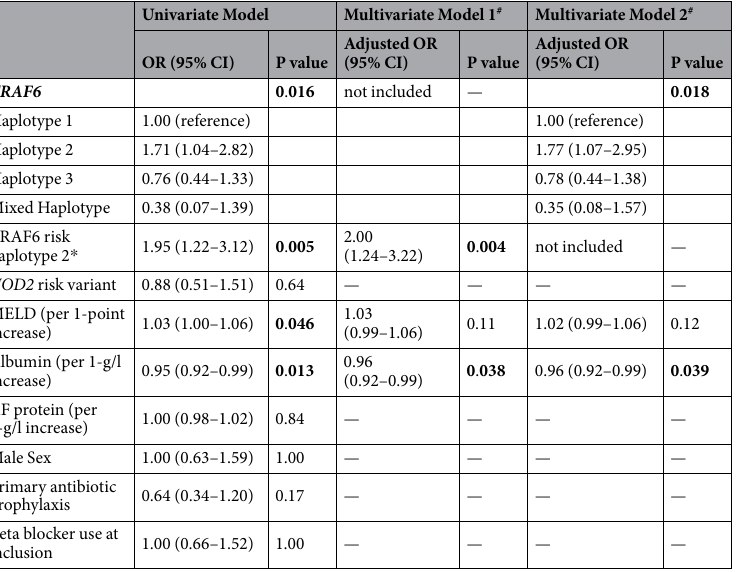
Table 2. Risk factors for a first episode of spontaneous bacterial peritonitis. # Binary logistic regression with alternative models including either haplotype overall or the risk haplotype 2 as categorical variable. * Versus non-risk haplotypes 1, 3, and the mixed haplotype. ¶ Comprising quinolones, cotrimoxazole and rifaximin. Data available from 421 patients (97.5%). Abbreviations: odds ratio (OR), confidence interval (CI), tumor necrosis factor receptor-associated factor 6 (TRAF6), nucleotide-binding oligomerization domain-containing protein 2 (NOD2), model for end-stage liver disease (MELD), ascitic fluid